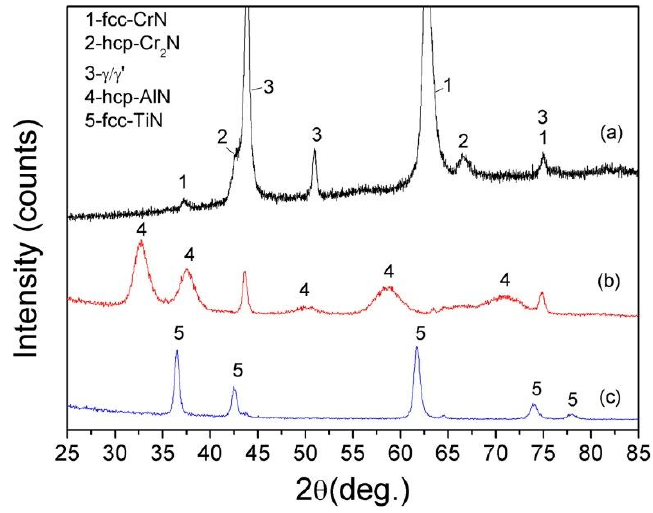
Figure 2. XRD patterns of as-deposited ( a ) CrN, ( b ) AlN and ( c ) TiN film.